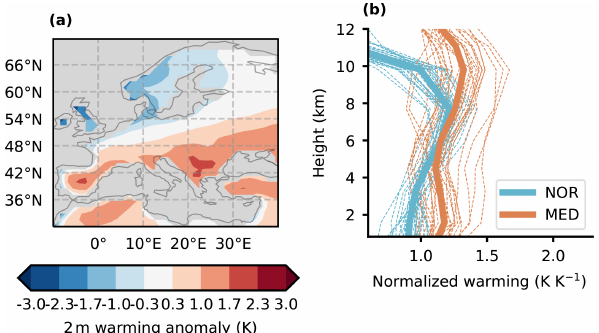
Figure 9. The Mediterranean amplification in CMIP6 simulations. (a) Ensemble mean summer near-surface warming anomaly with respect to the ensemble mean of Northern Hemispheric land grid points (0–70 ◦ N). (b) Mean vertical warming profiles over the Mediterranean (MED; orange) and northern Europe (NOR; blue) in summer. The thin dashed lines show individual ensemble members, and the bold line shows the ensemble mean. The MED is evaluated between 30 and 44 ◦ N and 10 ◦ W and 40 ◦ E, while NOR is eval- uated between 55 and 70 ◦ N and 0 and 40 ◦ E, and only land grid points are used. The warming has been normalized by the mean warming on 925hPa over NOR and